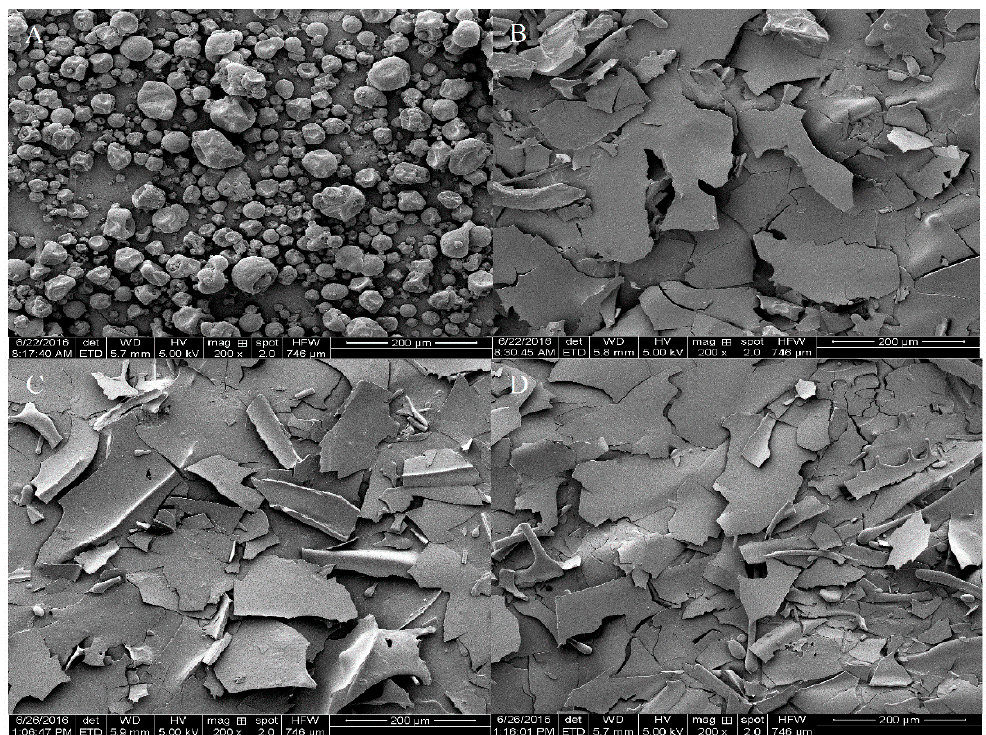
Figure 5. Scanning electron micrographs of SPI formed from non-HPH treated SPI ( A ); 10 MPa HPH-treated SPI ( B ); 40 MPa HPH-treated SPI ( C ); and 80 MPa HPH-treated SPI ( D ).